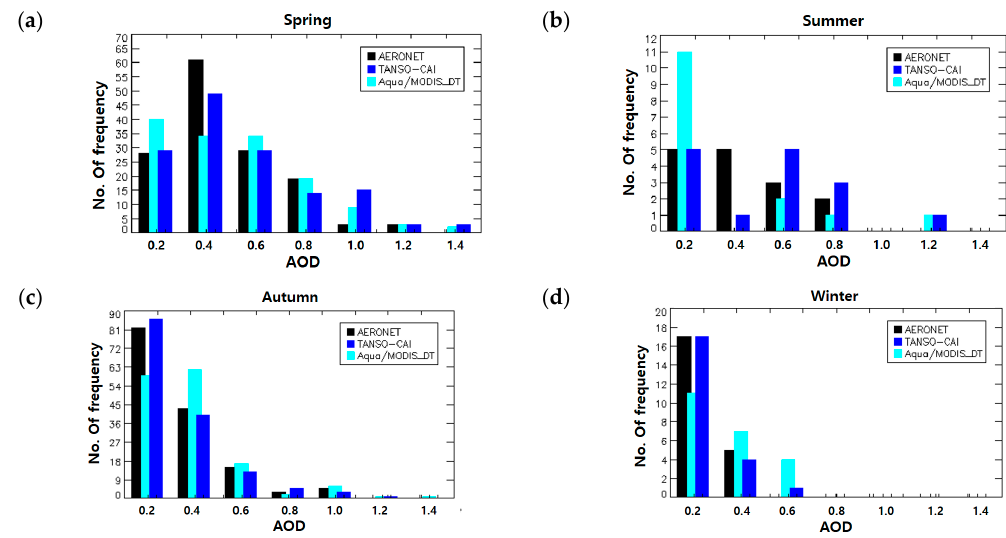
Figure 9. Frequency number of AODs retrieved by AERONET, Aqua/MODIS, and TANSO-CAI measurements at AERONET sites from June 2009 to December 2013 in ( a ) spring; ( b ) summer; ( c ) autumn; and ( d ) winter. Where, AODs of Aqua/MODIS and TANSO-CAI were averaged by 0.3° grid box.